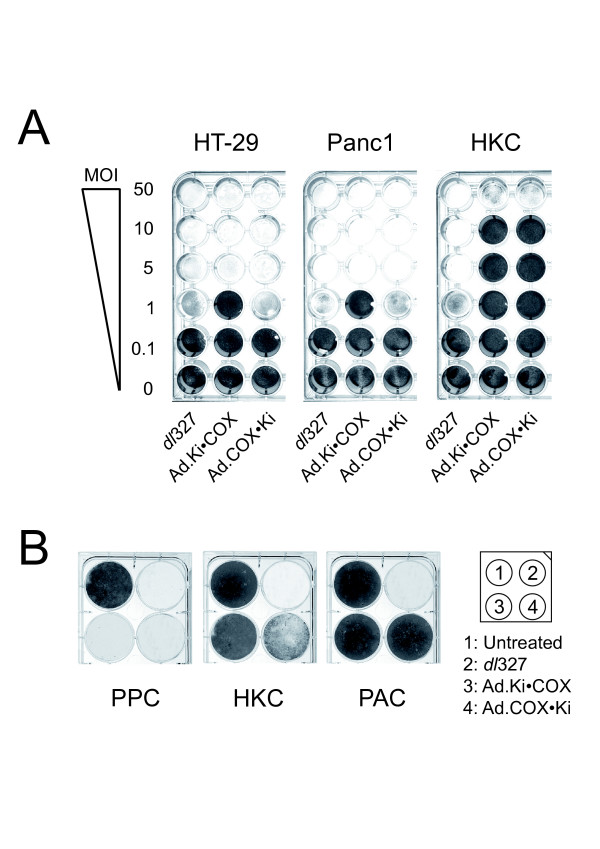
Adenoviral cytopathic effect assay. Panel A: Monolayers of HT-29, Panc1, and primary human keratinocytes (HKC) were infected with serial dilutions of dl327, and adenoviral vectors carrying the adenoviral E1A region and E4 under the transcriptional control of the COX-2 or Ki-67 promoter, respectively. The indicated MOI (PFU/cell) was determined for each cell line individually. Panel B: monolayers of primary pancreatic carcinoma cells (PPC), HKC, and primary adenoid cells (PAC) were left untreated or infected at an MOI of 5 PFU/cell (determined for each cell line individually) with dl327, Ad.Ki•COX or Ad.COX•Ki, respectively. Five days later, the cells were washed and stained. One representative experiment out of three is shown.